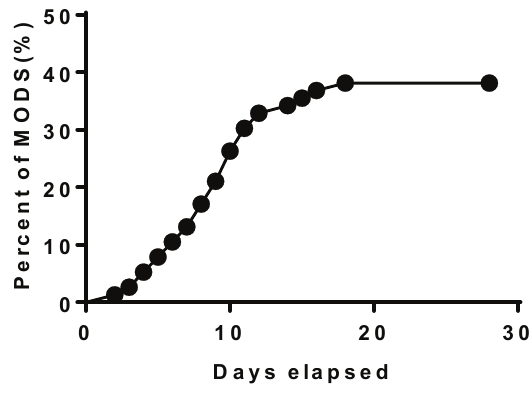
Figure 1: MODS risk in severe burn patients between PBDs 1 to 28.